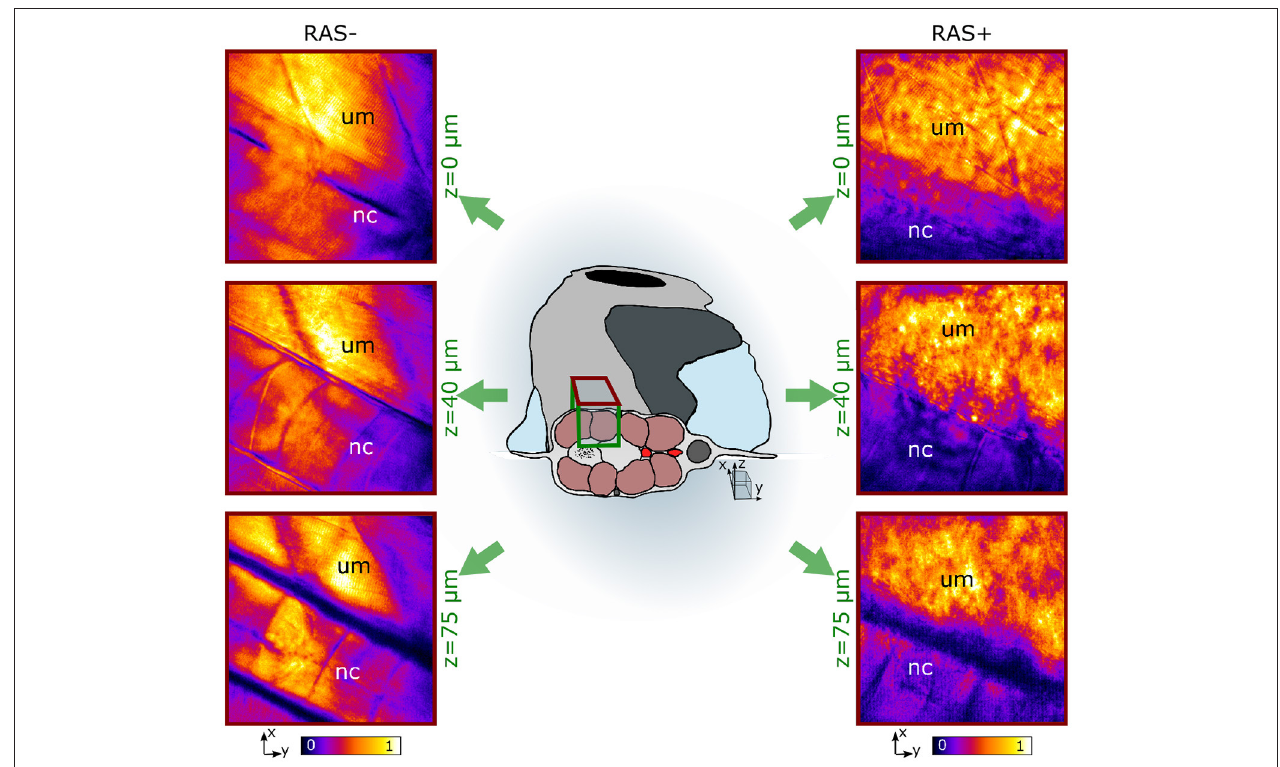
Figure 3 shows representative images of the lipid distribution in depth for 120 hpf larvae. In healthy larvae, the well-organized lipid distribution is clearly visible. The corresponding CARS signals are coming from lipid-rich structures within the dorsal myotome (um), where muscle fibers are clearly visible. The myotomes are followed in depth through their lipid content. The notochord (nc) is also visible at depths from 40 to 75 µ m since its cell membrane structure is composed of a mixture of lipids and proteins. The CARS images of RAS+ fish have a totally different appearance. The organized lipid distribution from the muscle fibers found in healthy larvae can be barely identified at the surface. Deeper in the tissue this arrangement is completely lost and a cluster of high-intensity lipid signal is visible. We can identify a region, where there is high-clustered lipid content overwhelming the expected CARS signal coming from the muscle fibers at depths from 40 to 75 µ m as observed in the healthy case. This ROI corresponds to the enlarged spinal cord location, where RAS expressing cells are situated and are proliferating.